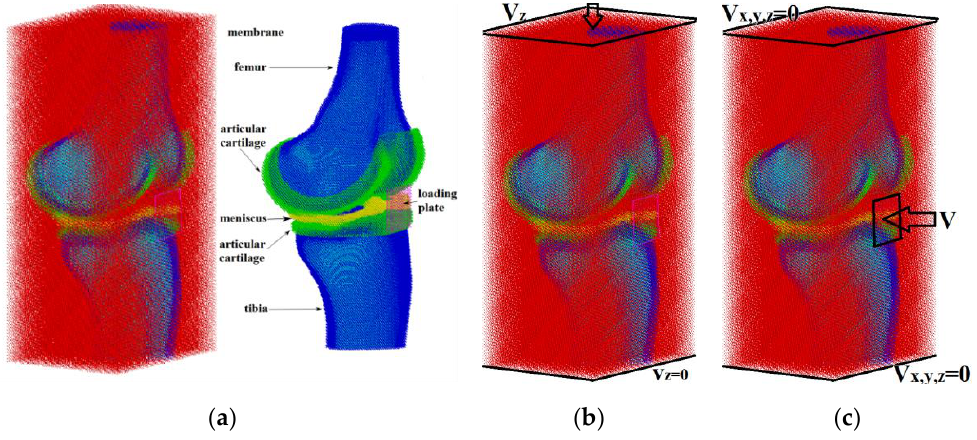
Figure 2. The model of the knee joint: ( a ) structure model of the knee joint; ( b ) loading conditions used for verification and validation; ( c ) loading conditions for simulation of the shock wave ex- posure.